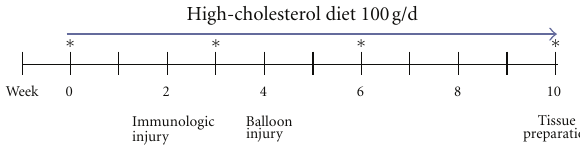
Figure 1: Schematic diagram of study timeline. Immunologic injury is followed by 2 weeks of high cholesterol feeding and balloon injury on week 4. ∗ Means the times of serum collection and animal body